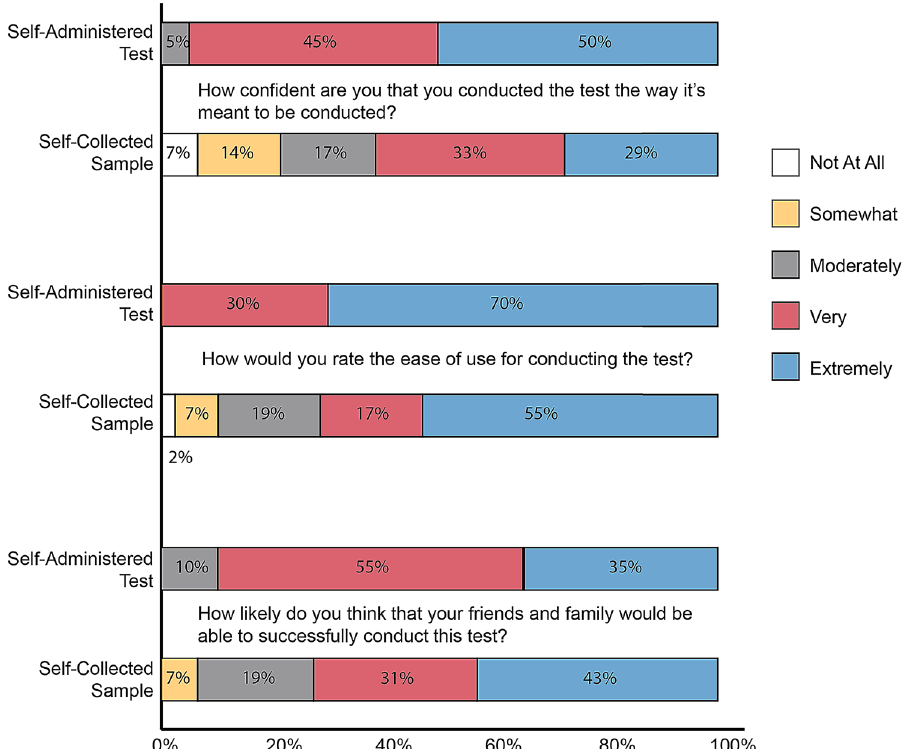
Figure 3. Evaluation for the independent use of BinaxNOW. Usability assessment following self-administration, with parent/caregiver (n = 17) or oneself (adolescent) (n = 3) and adult self-collected sample (n = 42). Self- collection reflects confidence in sample collection. Self-administration reflects confidence in completing assay (assay development, interpretation,